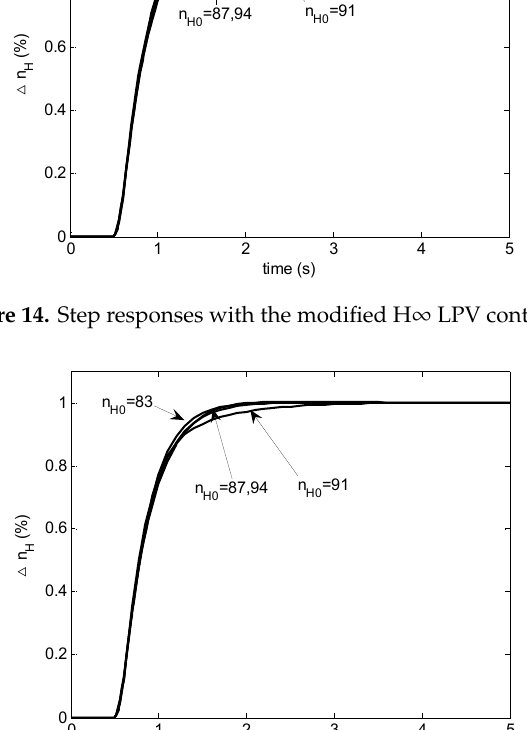
Figure 15. Step responses with the frozen-parameter H ∞ Figure 15 Step responses with the frozen-parameter H ∞ controller. Figure 15 Step responses with the frozen-parameter H ∞ controller.